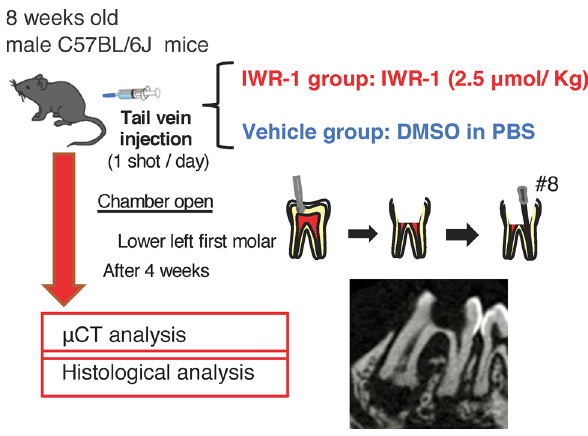
Figure 1. In vivo inhibition model of the Wnt/β-catenin signaling pathway. The pulp chamber of the lower first molar was exposed to the oral cavity. IWR-1 or DMSO in PBS was administered into the tail vein once a day from the day of pulp exposure. At 4 weeks after the first administration, the periapical lesions were evaluated by micro-CT and histological analysis. A representative image for the micro-CT is